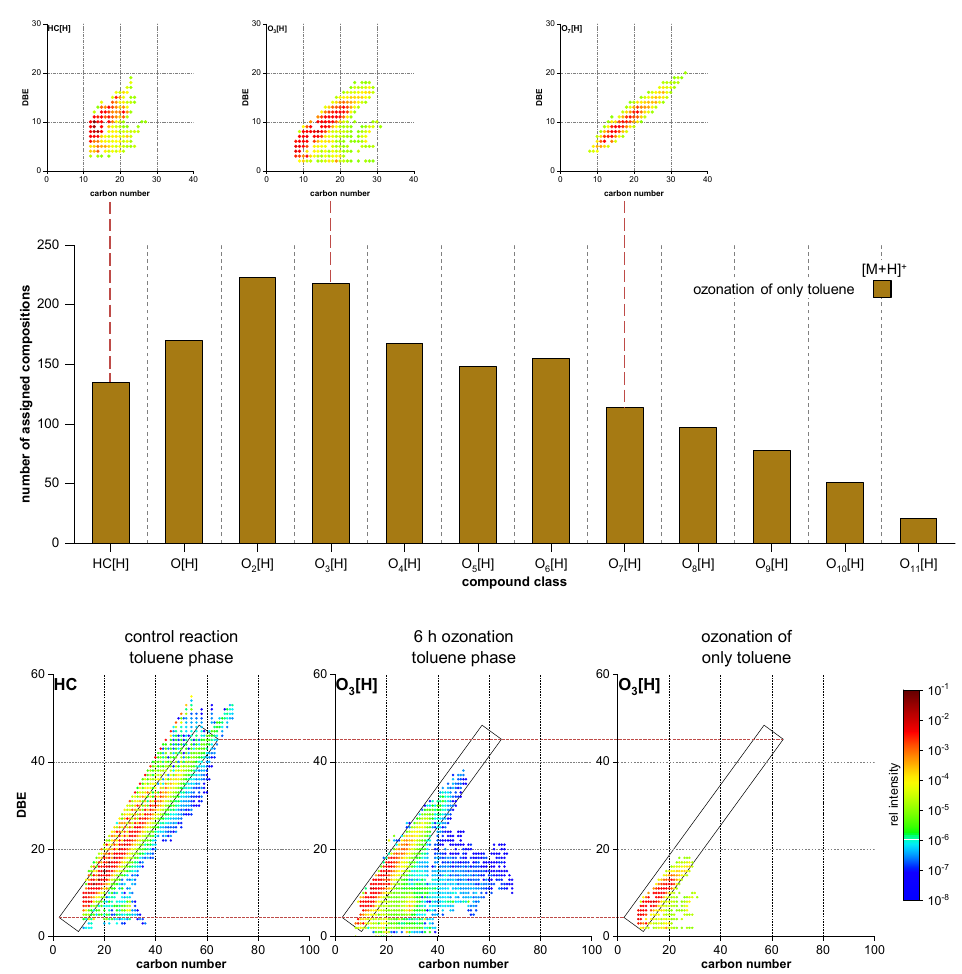
Figure 7. Kendrick plots for HC[H], O 3 [H], and O 7 [H] classes and population based class distribu- tion of hydrocarbons and oxygenated compounds after ozonation of only toluene (top graph) and Kendrick plots of control reaction, 6 h ozonation, and ozonation of only toluene (bottom graph).